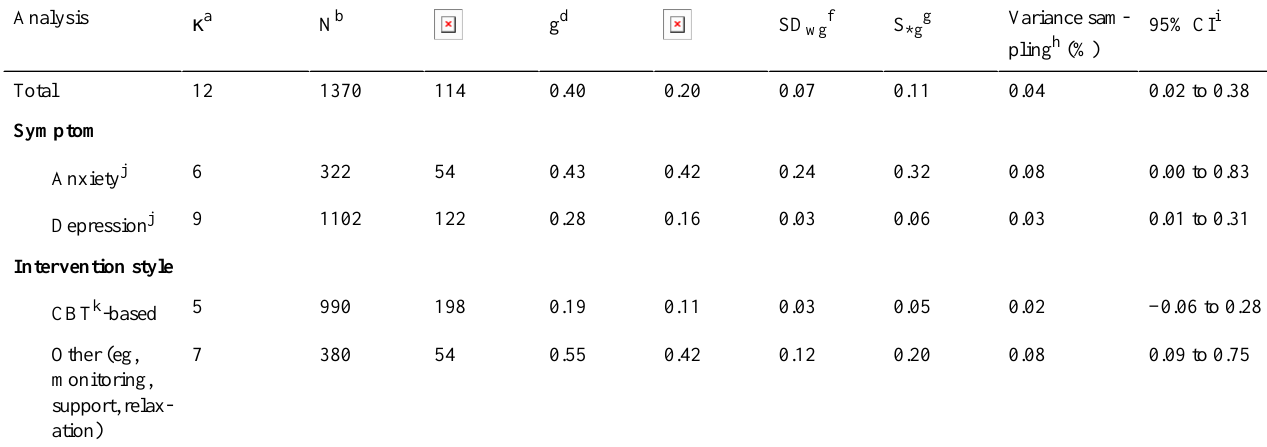
Table 2. Effectiveness of smartphone-based interventions on reducing youth internalizing disorder symptoms, overall, by primary targeted outcome, and by intervention